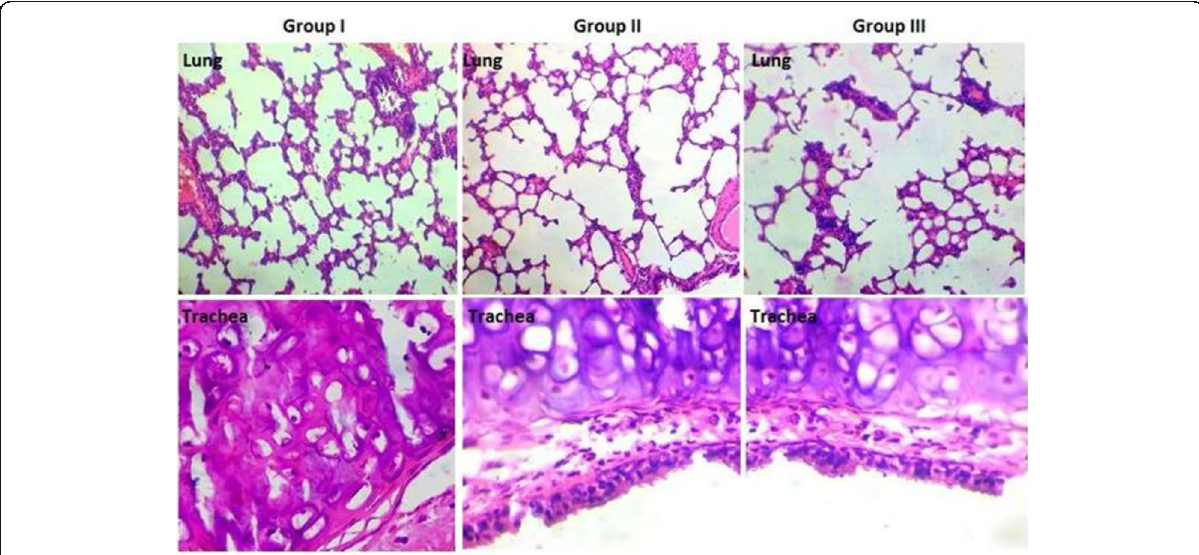
Fig. 7 In vivo tissue toxicity study of RES-DPI and RES-NC-DPI in male Wister albino rats after intra-tracheal administration. The histopathological examination of tissue sections of the lung and trachea was done at a magnification of 40x